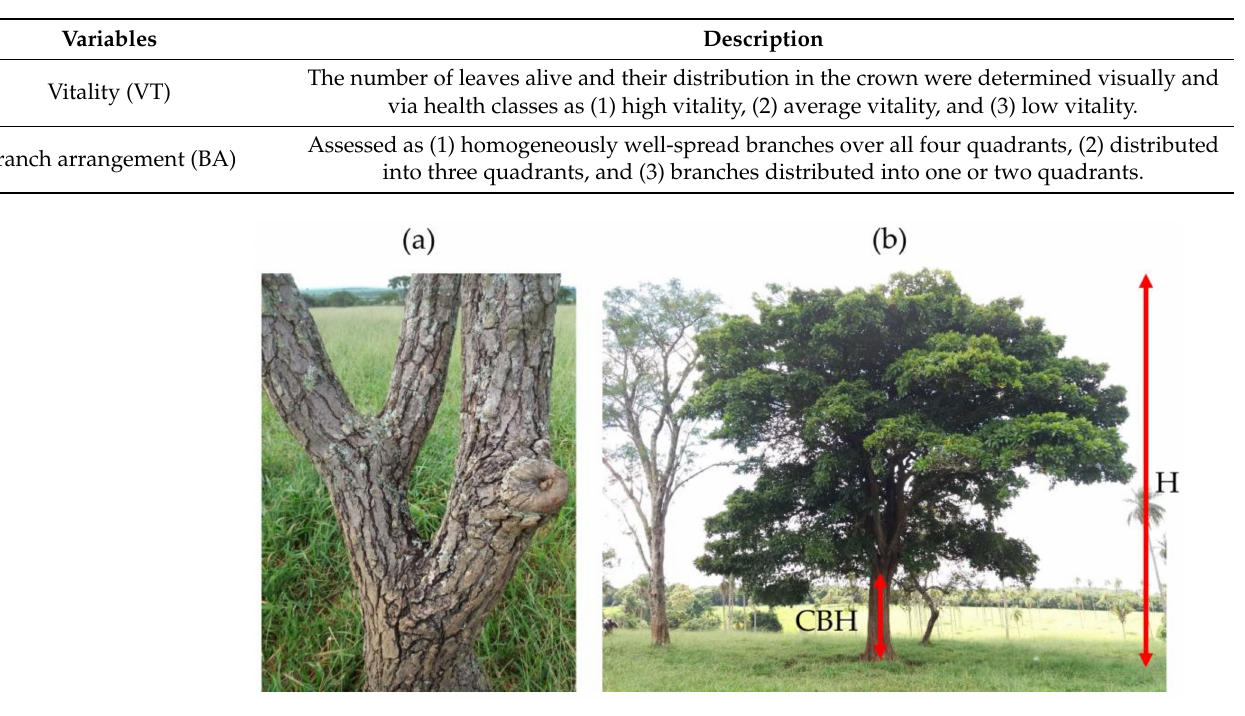
Figure 2. Dendrometric measurements obtained for the trees: equivalent diameter—Deq ( Caryocar Brasiliense Cambess.) ( a ), crown base height—CBH, and height—H ( Pouteria ramiflora (Mart.) Radlk.) ( b ), in which CBH refers to crown base height and H to total height.